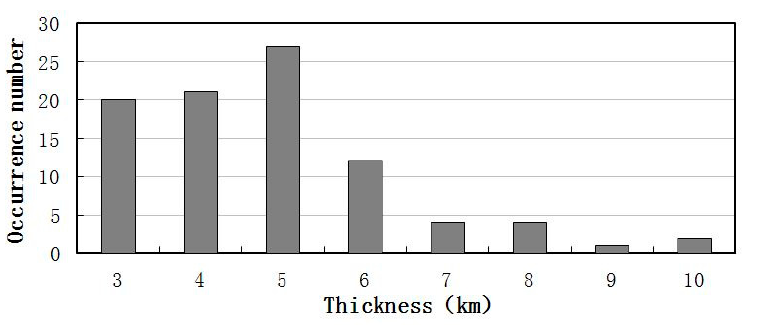
Figure 6. Distribution of occurrence numbers of lower-MIL thickness observed over Beijing.